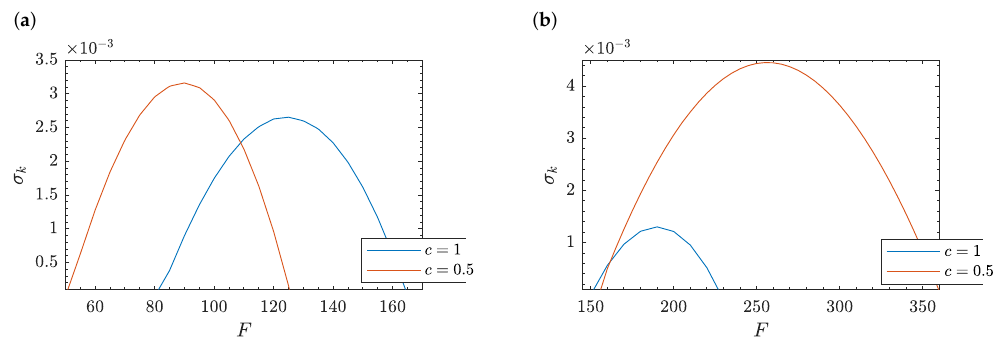
Figure 3. Effect of scaling the perturbation as y → cy at the maximum transient growth location, for a streak intensity of ( a ) A s